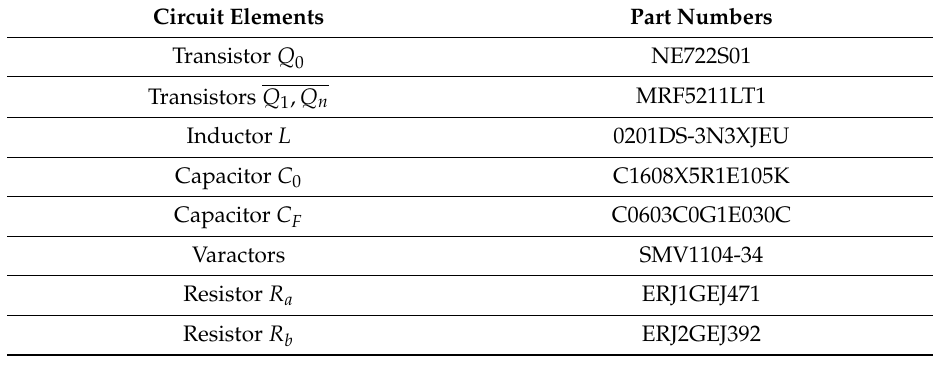
Table 3. Part numbers used in the designed voltage-controlled oscillator.